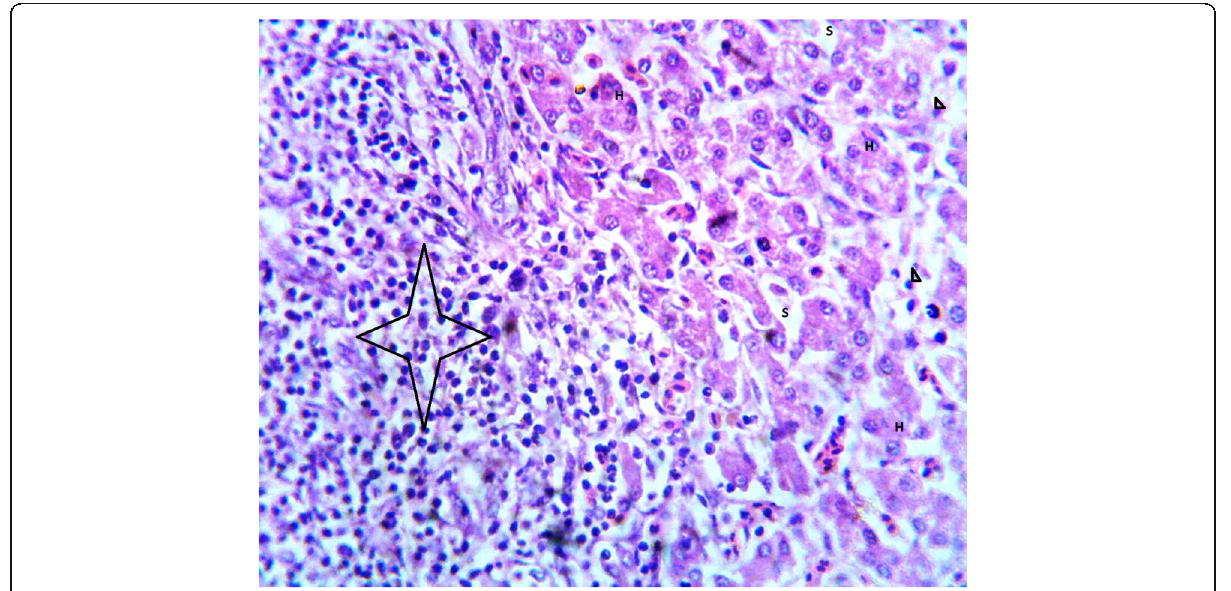
Fig. 6 Representative micrograph of liver section (× 400) of broiler chicks fed 1.0% PCM supplemented diet. This section shows the proliferation of polymorphonuclear and mononuclear cells (arrow and star), activation of liver macrophage system, the Kupffer cells